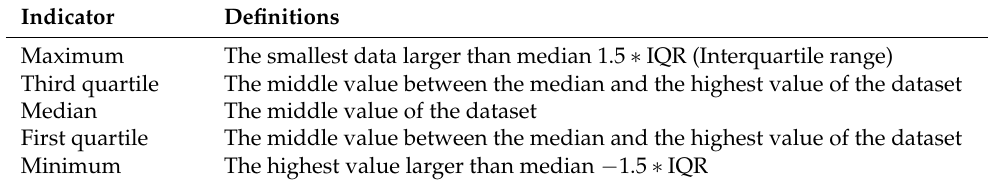
Table 5. Relative error of different methods.